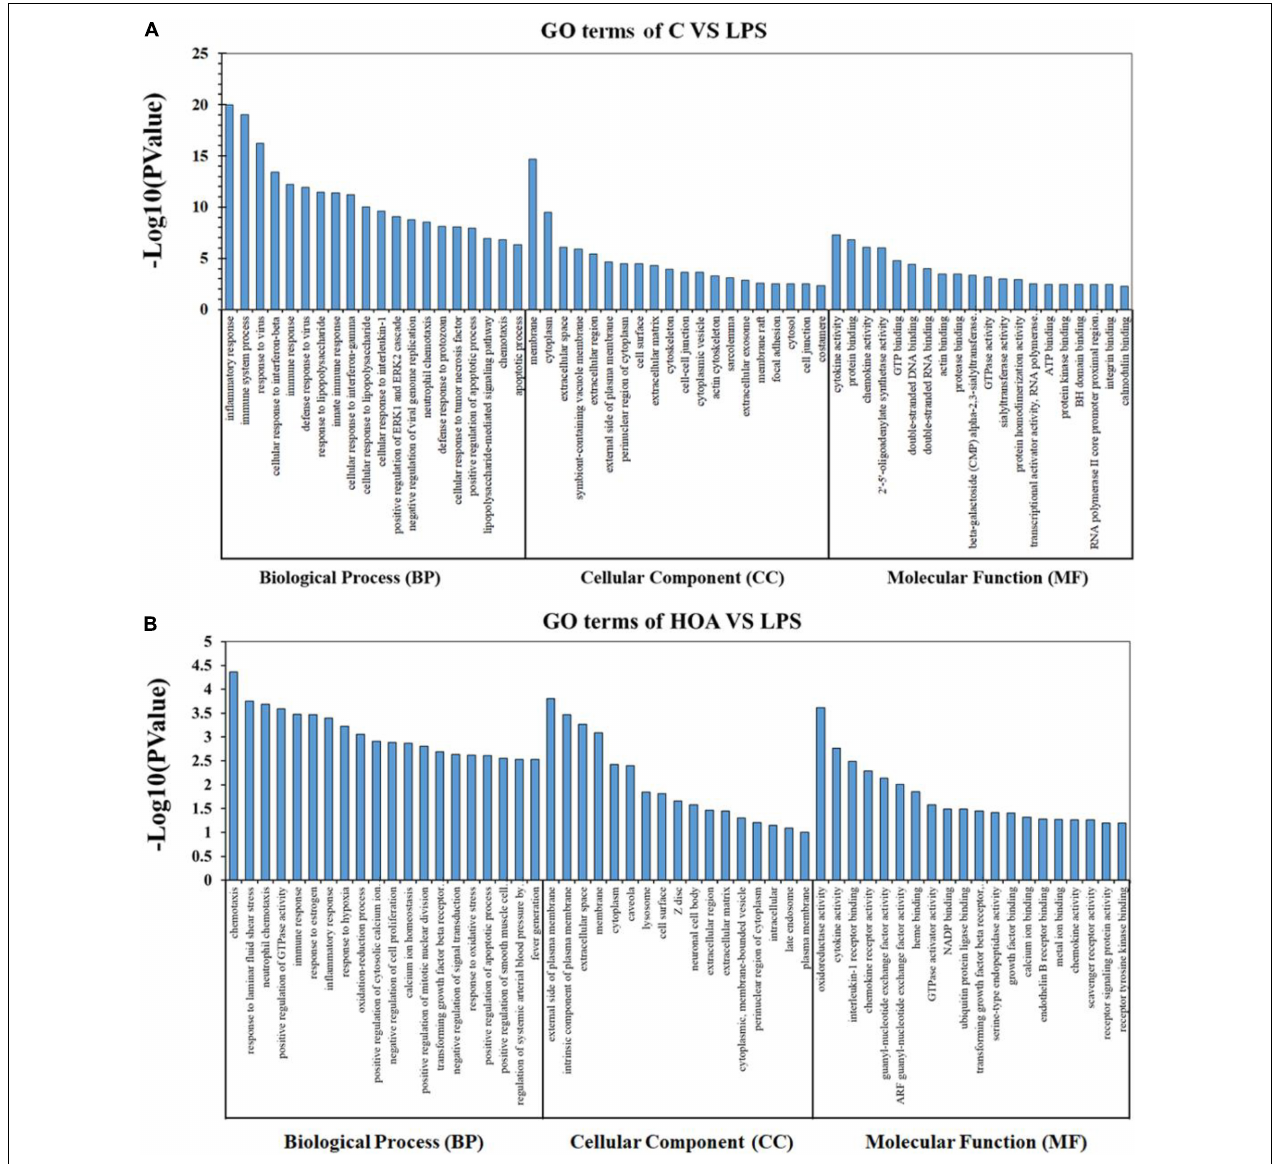
FIGURE 4 | Gene Ontology (GO) classification for functional enrichment analyses with the differentially expressed genes (DEGs) in C vs. LPS (A) and HOA vs. LPS (B) . The top functional enriched classes of DEGs were annotated into three sub-ontology: Biological processes (BP), cell components (CC), and molecular function